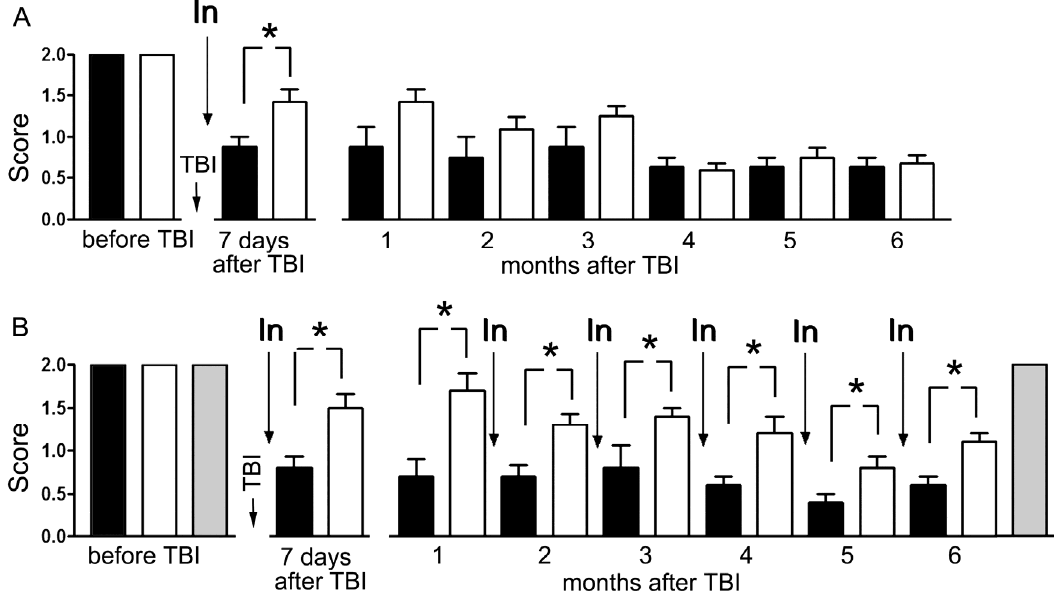
Figure 2. E ff ect of methylene blue on the neurological deficit in the right forelimb caused by traumatic brain injury (TBI) of the left sensorimotor cortex. The “grip strength test”. ( A ) A single administration of MB 30 min after the injury; ( B ) administration of methylene blue 30 min after the injury and then monthly (6 injections in total). Animals treated with saline solution after the trauma (black columns), animals treated with methylene blue after the trauma (white columns), sham-operated animals (grey columns). Injection of methylene blue or saline solution (In). * p < 0.05.